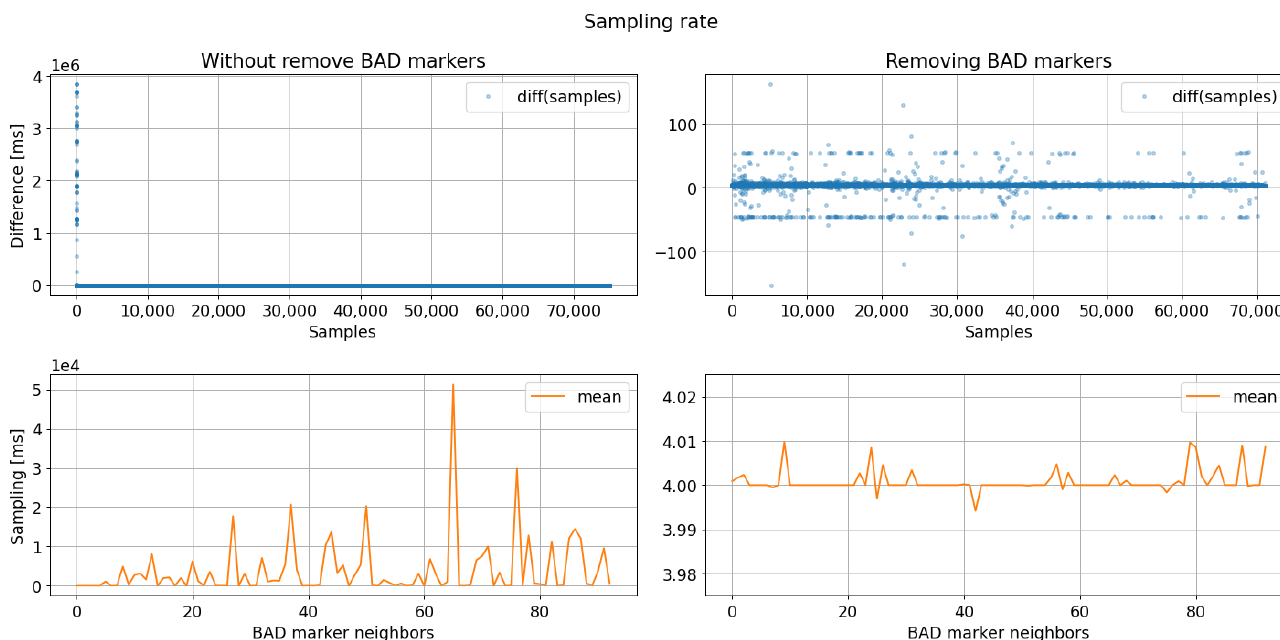
Figure 13. Sampling rate analysis results regarding bad markers removal. The sampling rate analysis after removing bad markers evidence a data period acquisition close to 4 ms (250